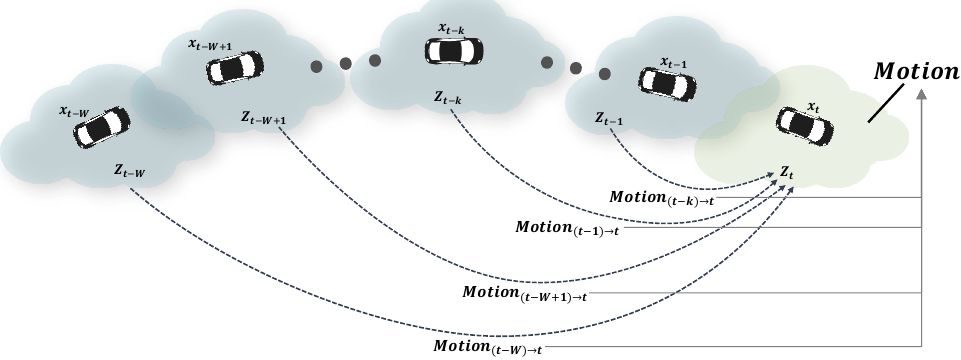
Figure 3. Motion probabilities p ( Motion ( t − 1 ) → t ) , · · · , p ( Motion ( t − W ) → t ) are integrated into the latest motion probability p ( Motion t ) .